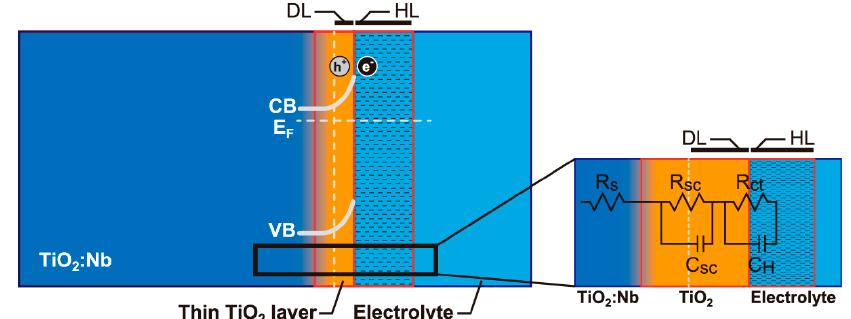
Figure 9. Energy diagram and electrical circuit analog for the TiO 2 / TiO 2 :Nb. The CB, VB, E F , DL and HL represent the conduction band, valance band, Fermi energy, depletion layer and Helmholtz layer, respectively.